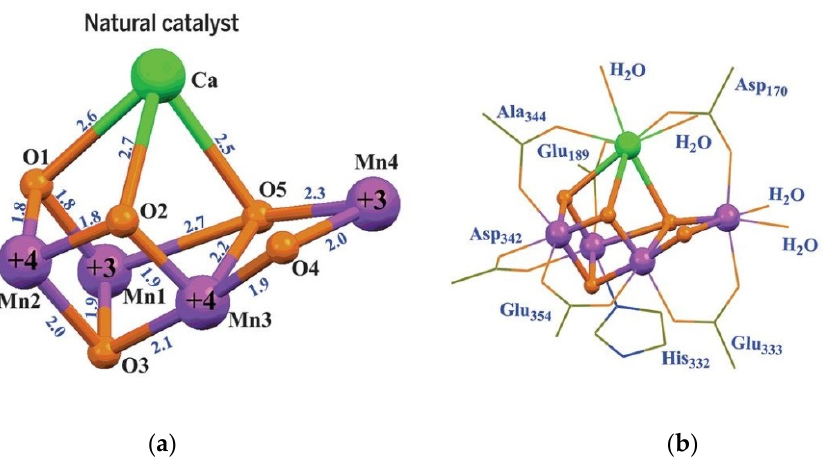
Figure 1. ( a ) Mn 4 CaO 5 core of oxygen evolution catalyst (OEC) in nature; ( b ) Structure of the native OEC, involving ligating protein side-chains and water molecules. The bond lengths are given in Å; Mn, purple; Ca, green; O, orange; All H atoms and CH 3 groups have been omitted for clarity [16]. Reprinted with permission from ref. [16]. Copyright 2015 The American Association for the Advancement of Science.